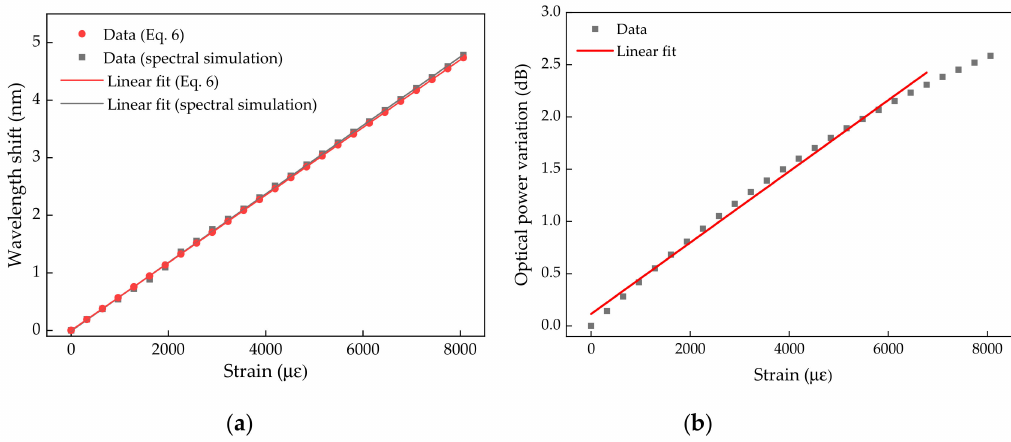
Figure 6. ( a ) Simulated wavelength shift as function of the applied strain considering Equations (1) and (6), and correspondent linear fit; ( b ) Simulated optical power variation as function of the applied strain, considering the integrated area from the convolution, given by Equation (5), and corresponding linear